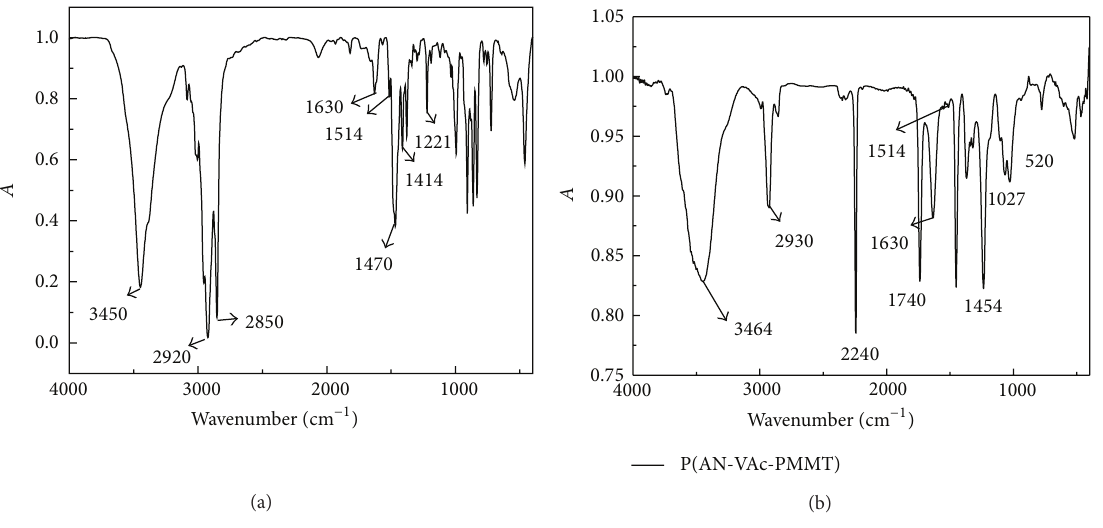
Figure 2: FTIR spectra of (a) MSDQA and (b) P(AN-VAc-PMMT).